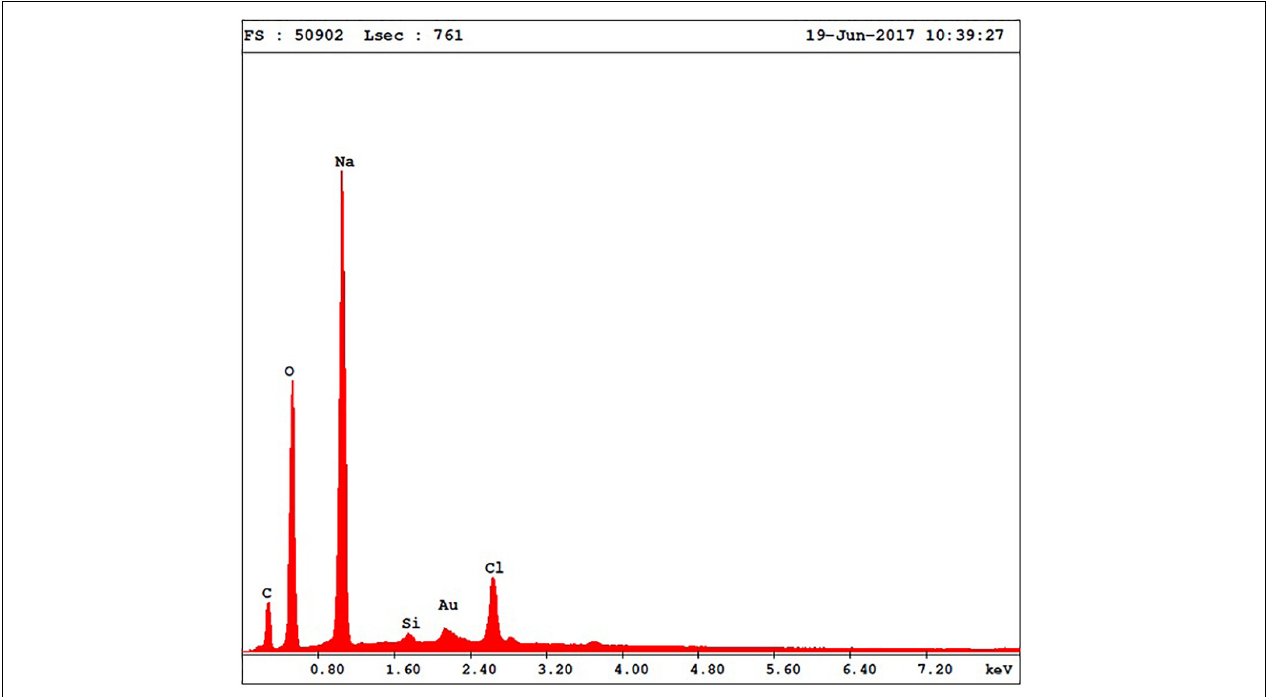
FIGURE 4 | EDX spectra of gold nanoparticles sample